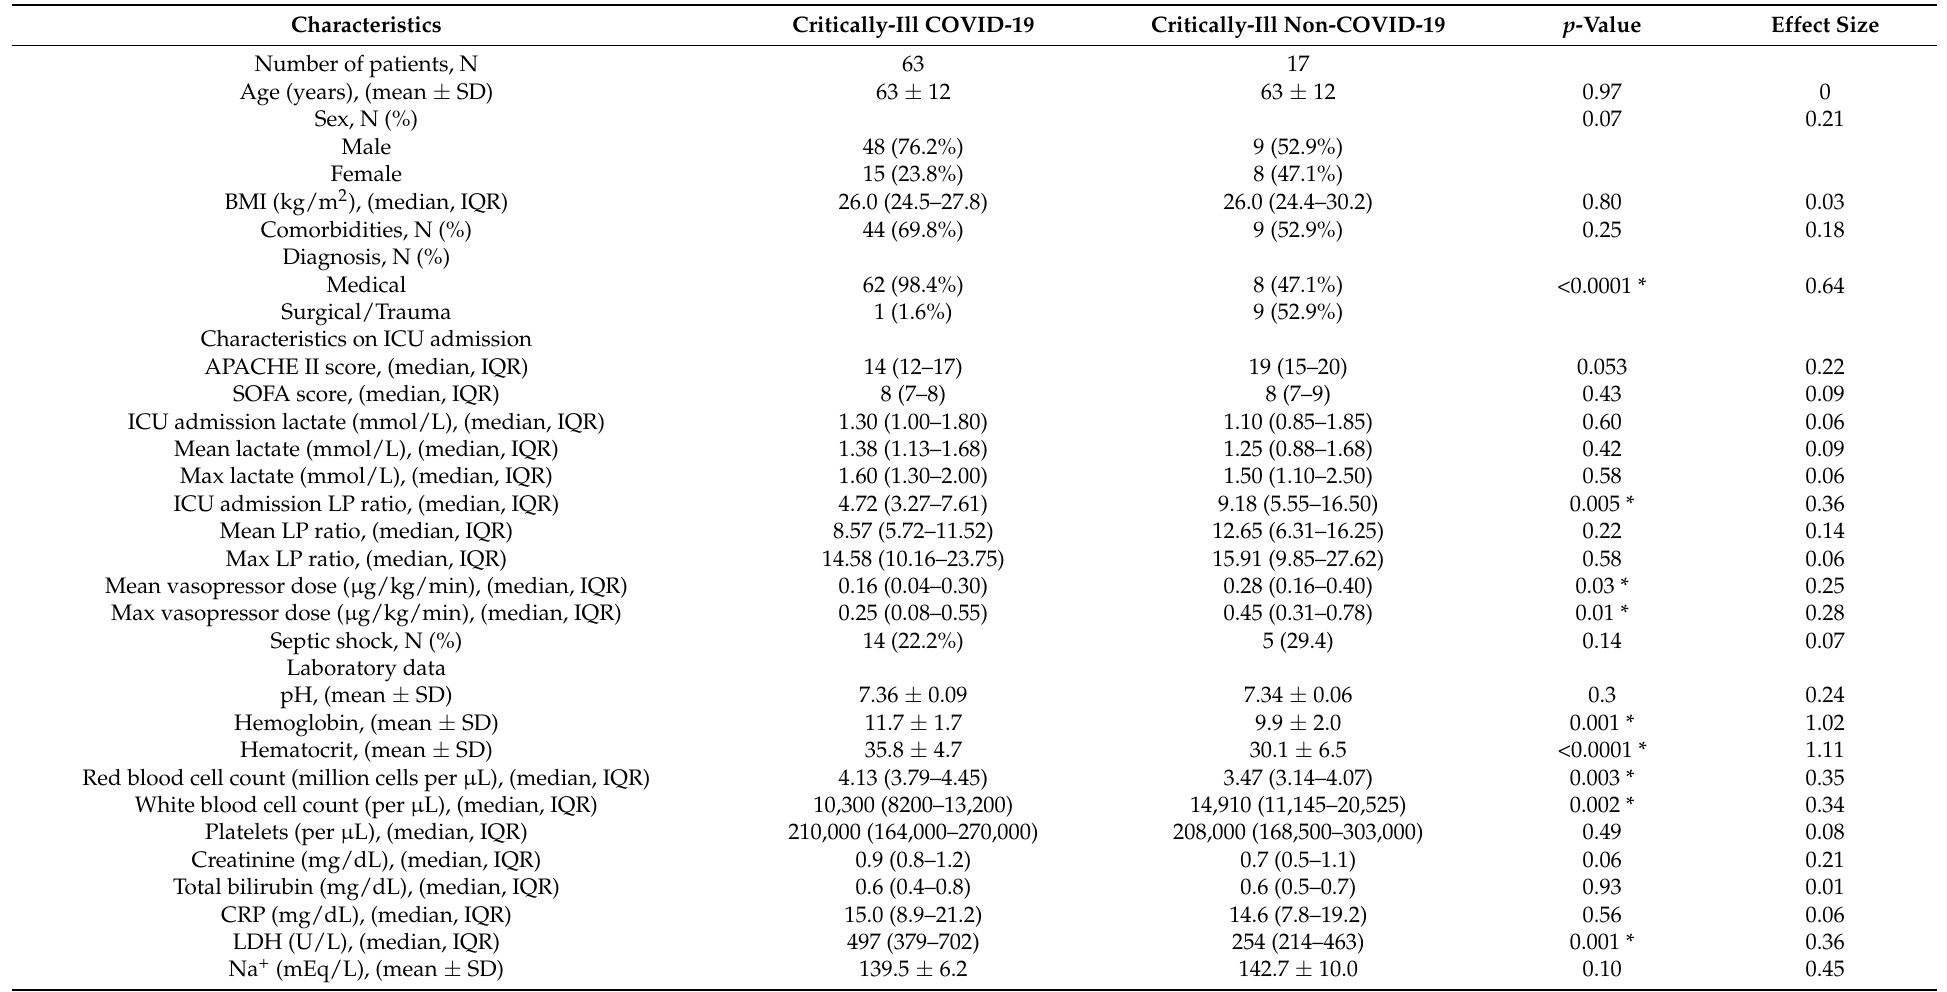
Table 1. Clinical characteristics and laboratory data in critically ill COVID-19 and non-COVID-19 patients on admission to the ICU. Patients’ outcome and demographics are also